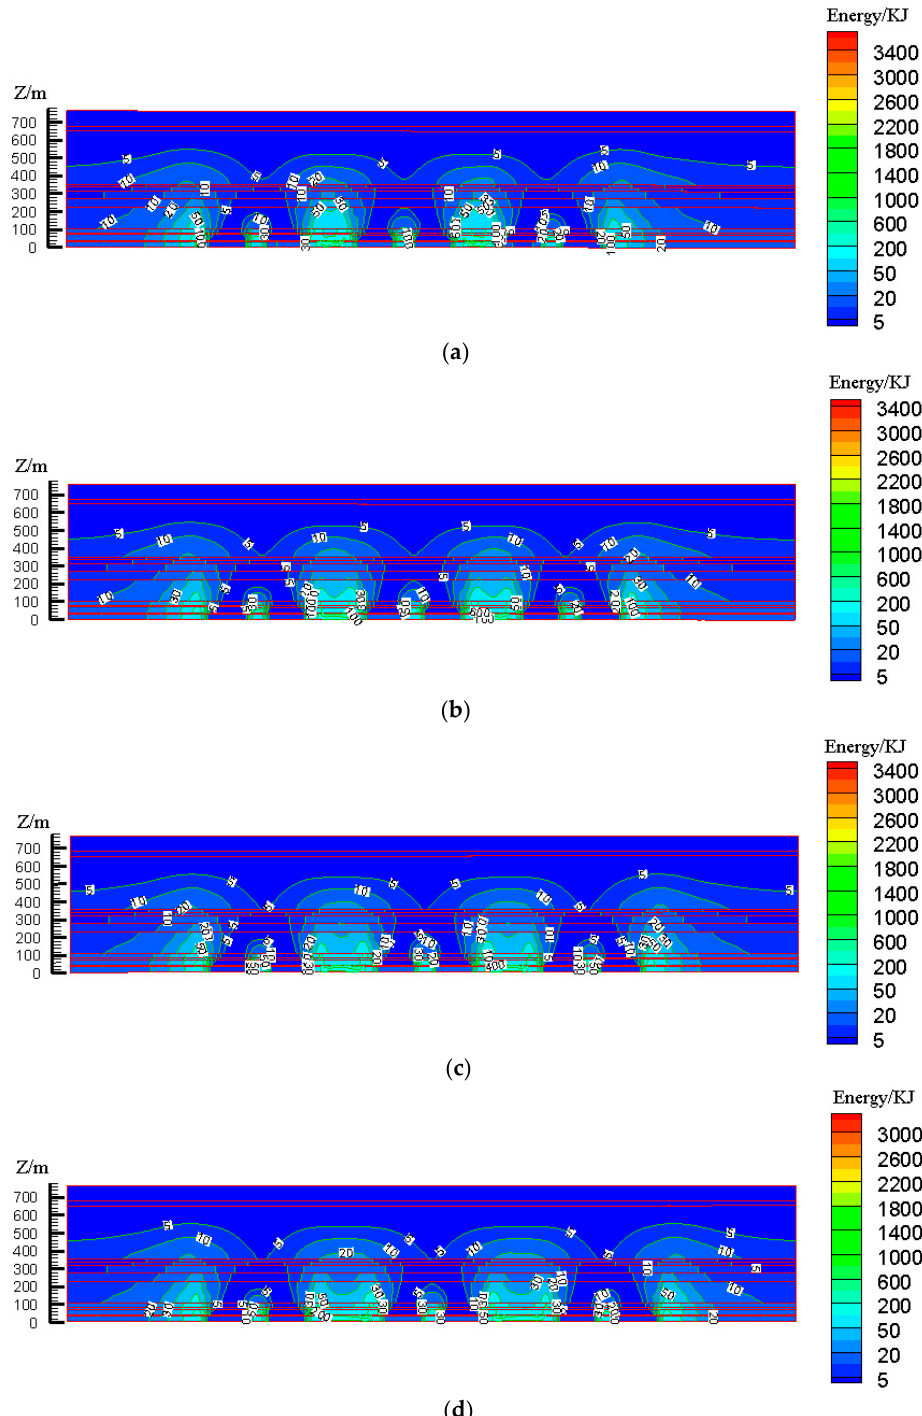
Figure 10. Strata and surface subsidence rule of partial filling mining based on the main key stratum under different filling face scales; ( a ) width of filling face =150 m. ( b ) Width of filling face =200 m. ( c ) Width of filling face =250 m. ( d ) Width of filling face =300 m.